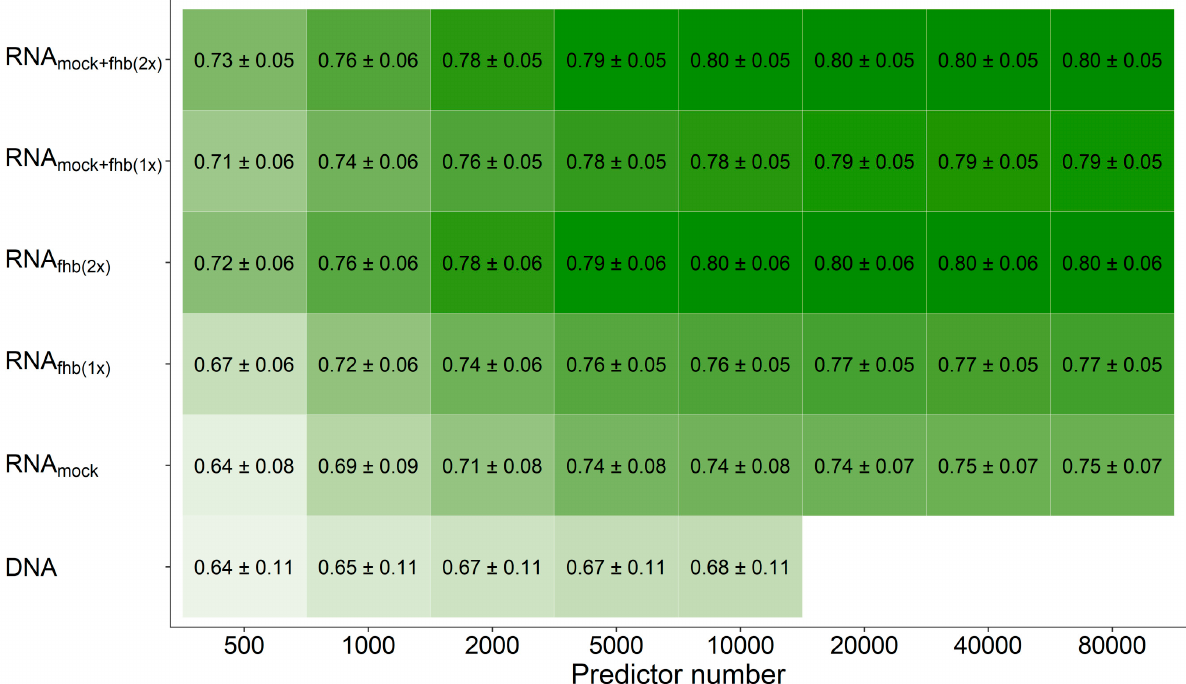
Figure 2. Average prediction ability using an increasing number of genomic and transcriptomic predictors. The merit of molecular markers (DNA) for fitting prediction models was compared with utilizing the individual feature matrices of the transcriptomic data obtained from mock-treated plants (RNA mock ) or Fusarium -treated plants (RNA fhb(1x) ), a combination from both Fusarium -treated replications (RNA fhb(2x) ) or from one mock-treated and one Fusarium -treated replicate at time (RNA mock+fhb(1x) ) as well as an integration of gene expression data from all treatment-by-replication combinations (RNA mock+fhb(2x) ). Darker coloring indicates a higher average prediction ability.